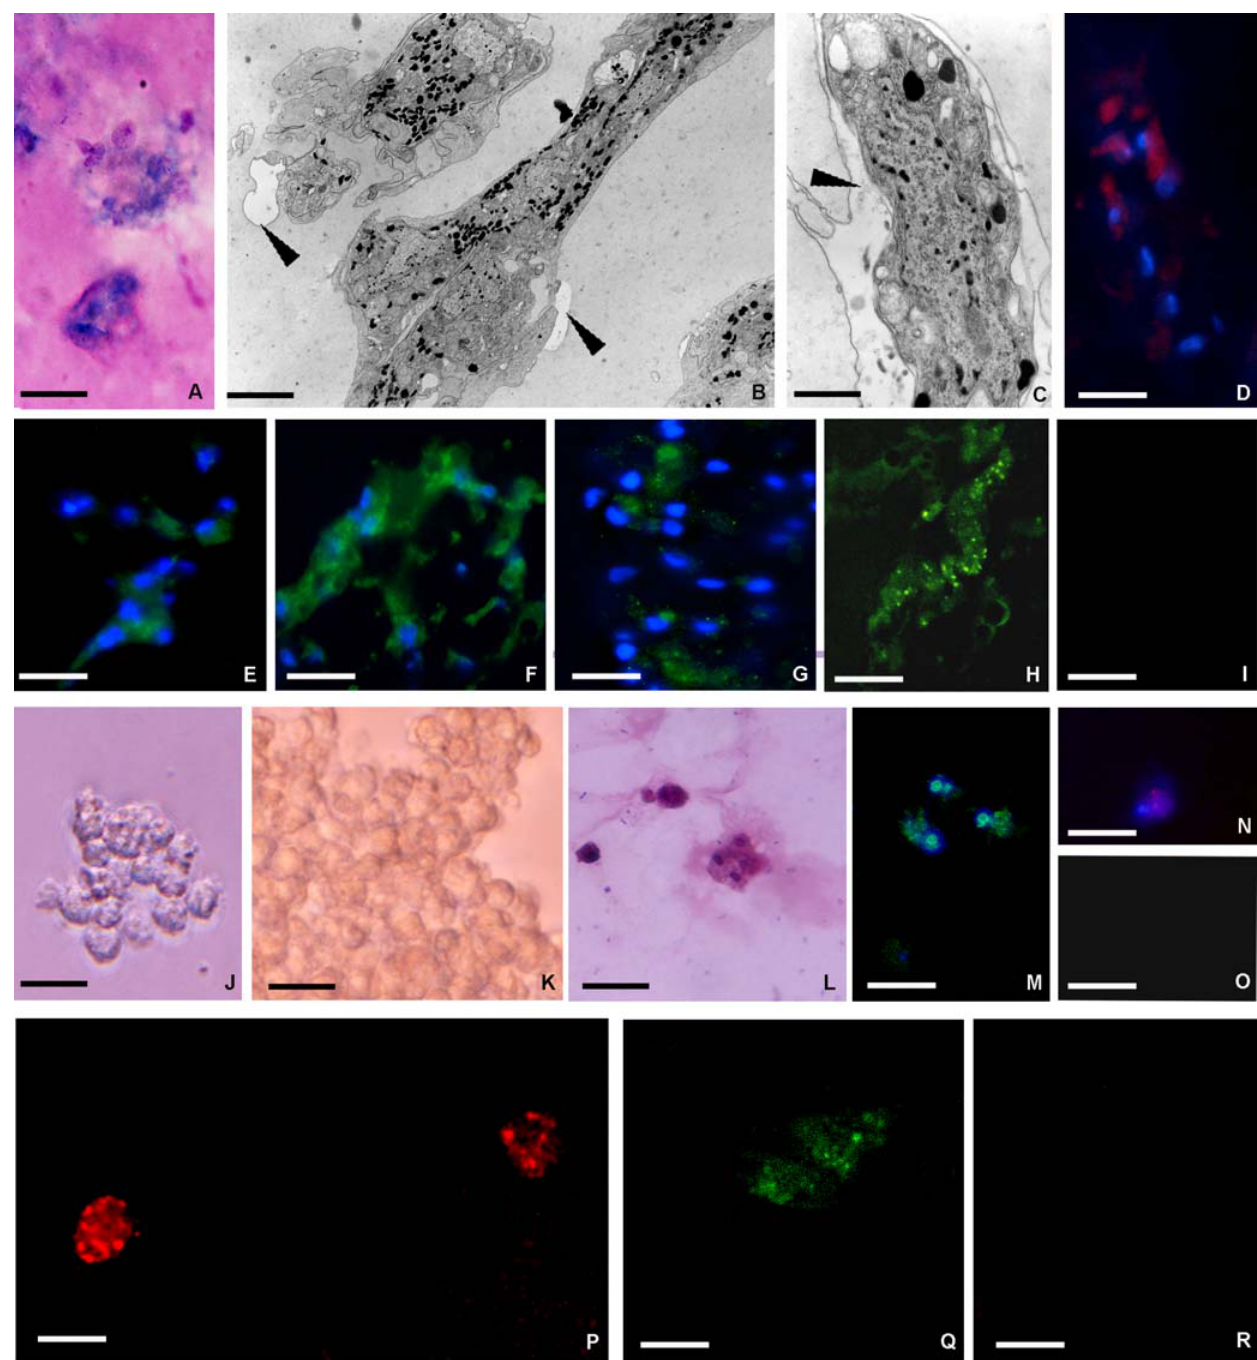
Figure 3. Analysis of the phenotype of cells recruited into the matrigel sponges by MCP-1/CCL2. MCP-1/CCL2 induces the mobilization of cells from tissues surroundingtheMG implant into thebiopolymer that wasrecovered andprocessed forstructural,ultrastructural immunocytochemical analysis orseeded for cell culture (A–O). After1 week in vivo thematrigel implant containedgranularcellsthatstained with Giemsasolution(A)that were ultrastructurally similar (B) to those localized in the extracellular matrix (ECM) in stimulated leeches (Fig. 2C, arrowhead). These cells showed a cytoplasm filled with black granules (B,C). Again they were of a migratory phenotype with localized degradation of ECM(B, C arrowheads), and cathepsin B staining (D). Immunocytochemical characterization of cells infiltrating the MG supplemented with MCP-1/CCL2 (E–I). The cells expressed several markers typical of granulocytes: CD11c (E), CD14 (F), CD61 (G), CD68 (H); (I: negative control). After 1 week in vivo the MG was used to seed cell cultures (J–O). Phase- contrast images of granular cells obtained 3 days (J) and 1 week (K) post-seeding indicate increasing cell numbers (K). These Giemsa positive cells (L) also immuno-stained with a CD11c antibody (M), a marker of granulocytes, and with anti-BrdU (N) demonstrating that these cells attraversed S-phase in culture; O: negative control. After incubation with Dil-Ac-LDL, these cells also took up the fluorochrome-conjugated Ac-LDL (P). These results strongly indicate that the cells that migrated out of the matrigel in vitro consisted largely of cells maintaining a monocyte/macrophage function throughout in vivo and in vitro culture as indicated by expression of CD68 (Q, R). Bars: A, D, P–R 10 m m; B, C 1 m m; E–I 15 m m; J–O 20 m m